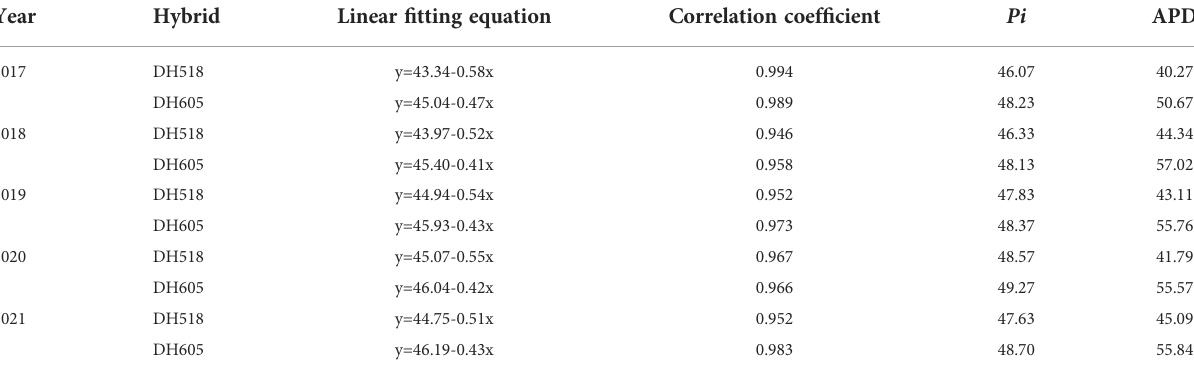
TABLE 5 Active photosynthesis duration of summer maize hybrids with different growth duration from 2017 to